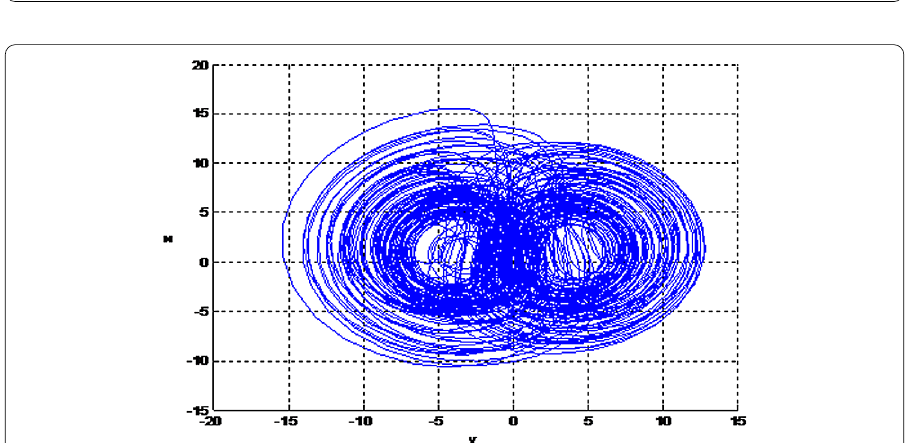
Figure 2 Chaotic attractor of system (2) in yOz plane with a = 5, b = 20, c = 1, d = 0.1, k = 0.1, e = 20.6, h = 1 and the initial state ( x 0 , y 0 , z 0 , w 0 ) = (3.2,8.5,3.5,2.0).